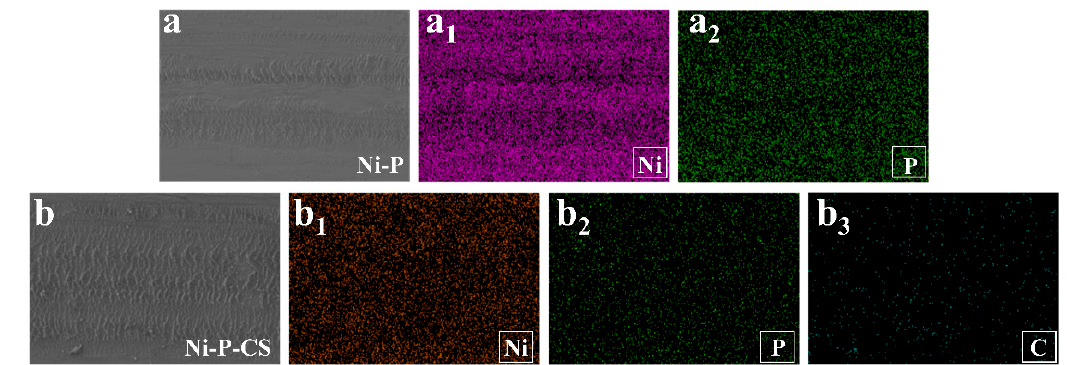
Figure 12. The EDS after friction and wear of the Ni-P coating and Ni-P-CS composite coat- ings.(( a ): SEM of Ni-P coating, ( a 1 ): Ni element, ( a 2 ): P element, ( b ): SEM of Ni-P-CS coating, ( b 1 ): Ni element, ( b 2 ): P element, ( b 3 ): C element).